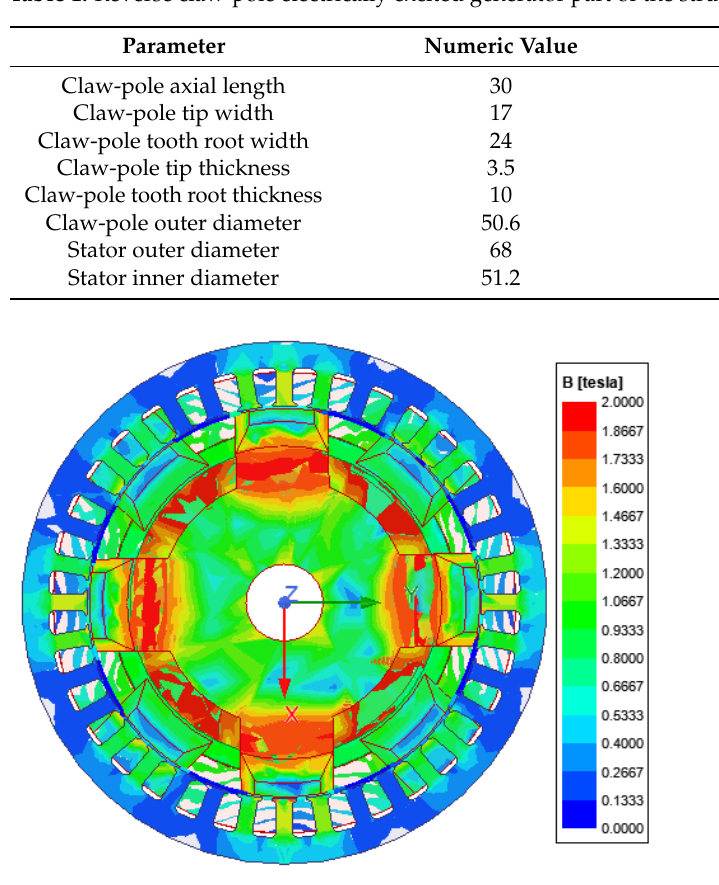
Figure 5. Flux density cloud of reverse claw-pole electrically excited generator.